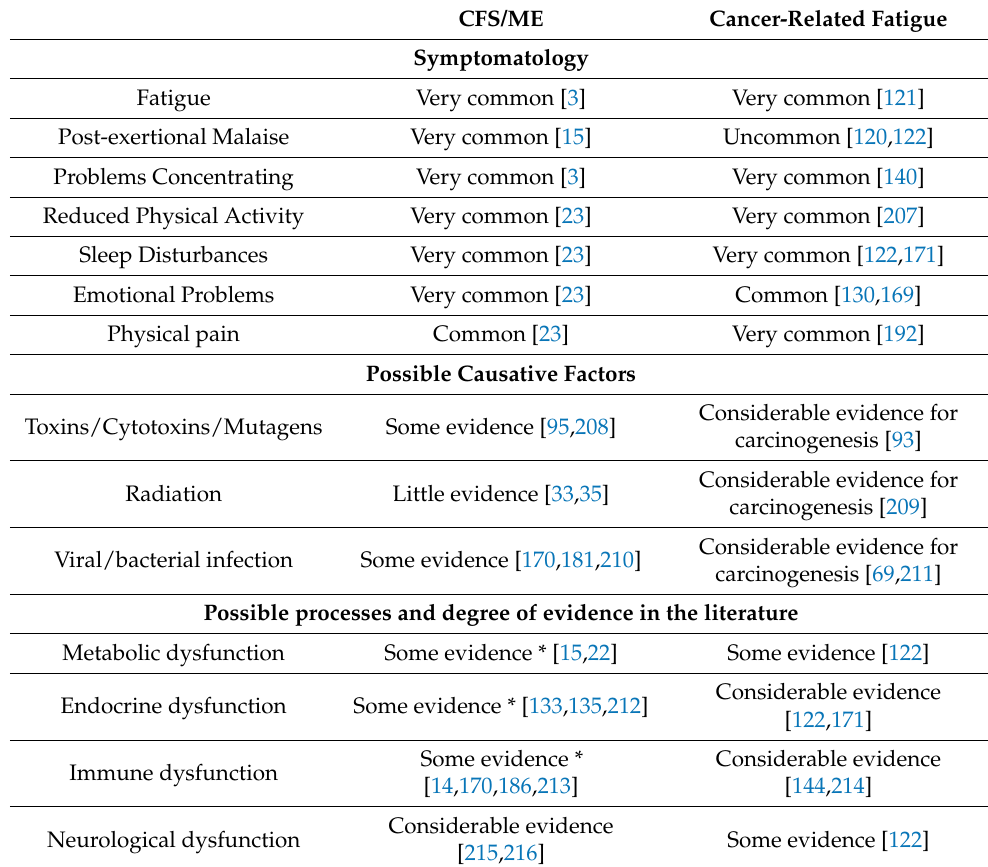
Table 1. A summary table comparing CFS/ME and cancer-related fatigue. Some symptoms and relative frequency are listed. Possible causative factors are also listed and are appraised on the amount of evidence in the current literature. Finally, possible biological processes are listed for both diseases, along with how much support appears to be present in the present literature. Entries marked with an asterisk continue to be contentious topics in the